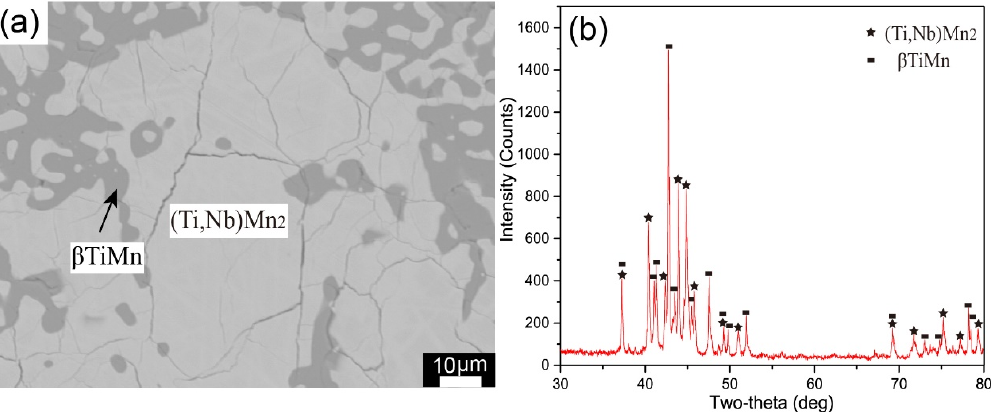
Figure 10. Alloy A8 annealed at 1173K for 90 days: ( a ) back-scattered electron (BSE) images, ( b ) XRD patterns.